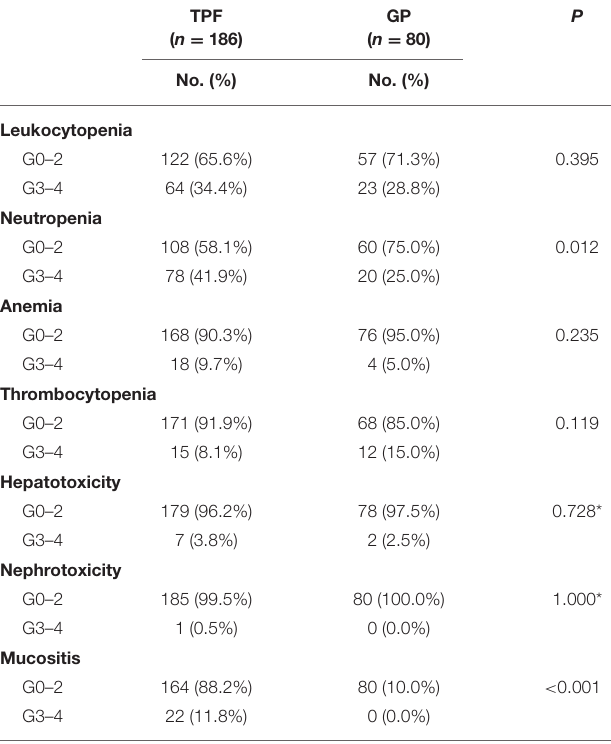
TABLE 5 | Acute toxicities during chemotherapy between the two